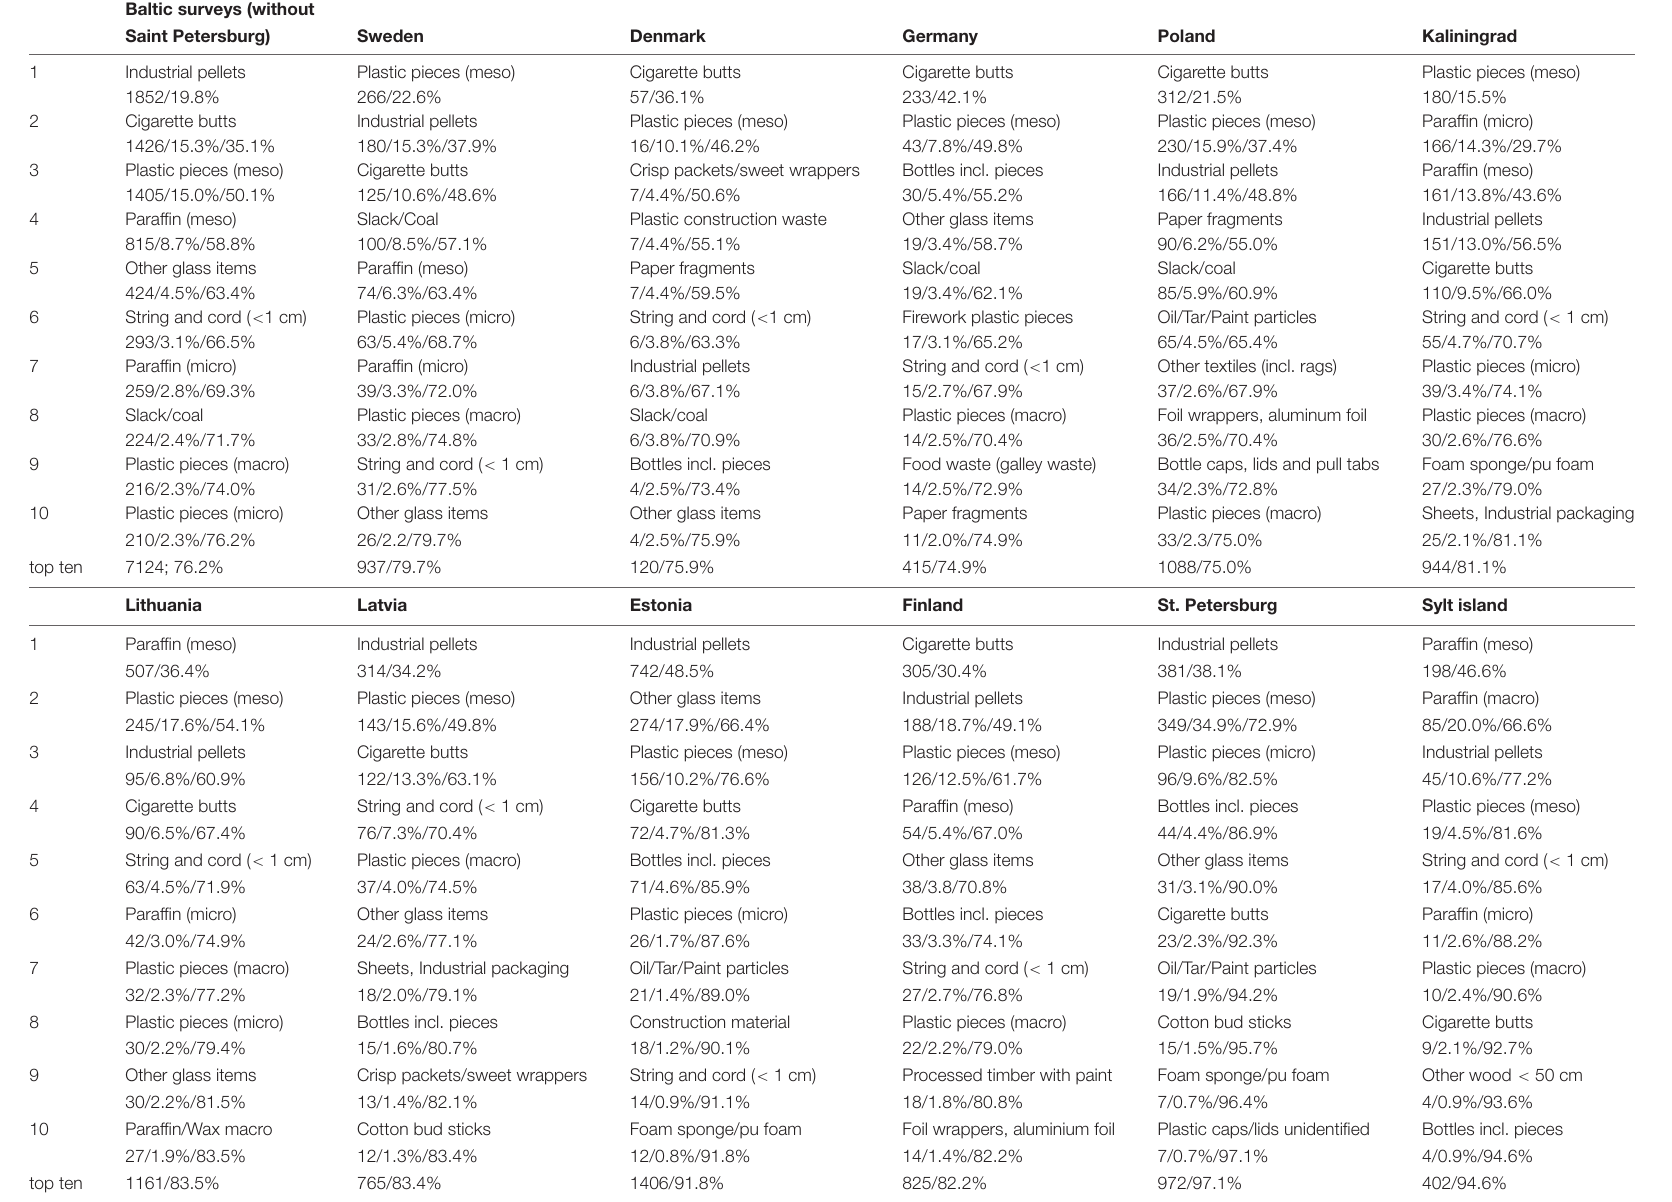
TABLE 2 | Top ten litter items per country, for all Baltic Sea surveys (cumulative) without St. Petersburg, and for the island of Sylt, Germany in the North Sea. Baltic surveys